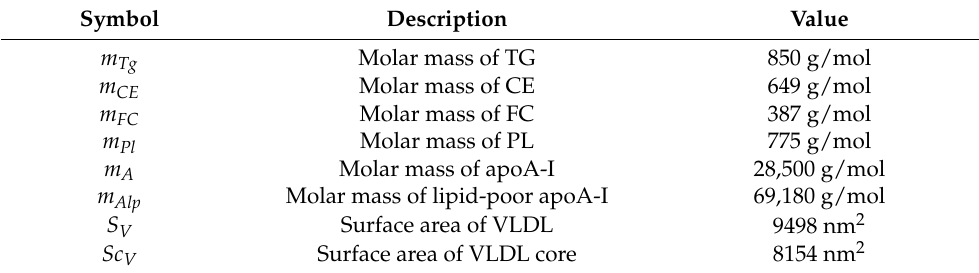
Table 3. Parameters used in the model.